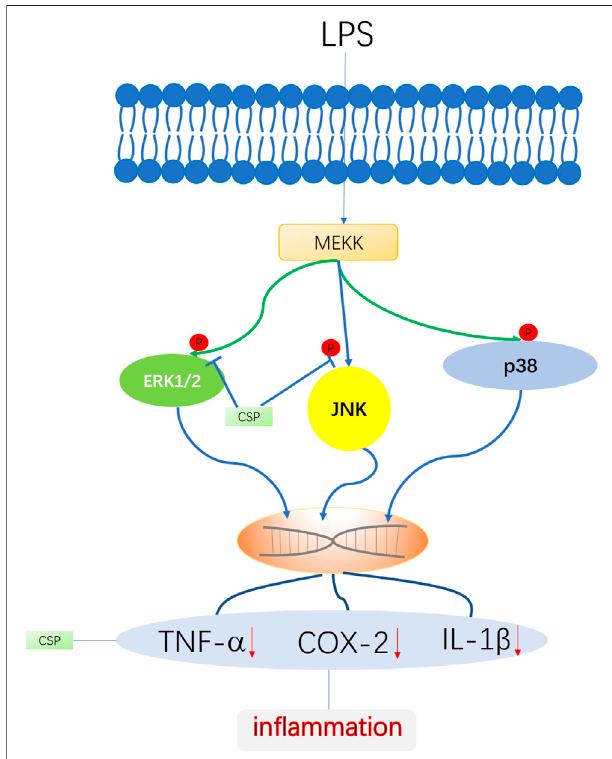
FIGURE9| Schematic diagram ofanti-in fl ammatory role ofCSP in LPS- induced NR8383 cells. CSP ameliorates in fl ammation via regulating of ERK and JNK